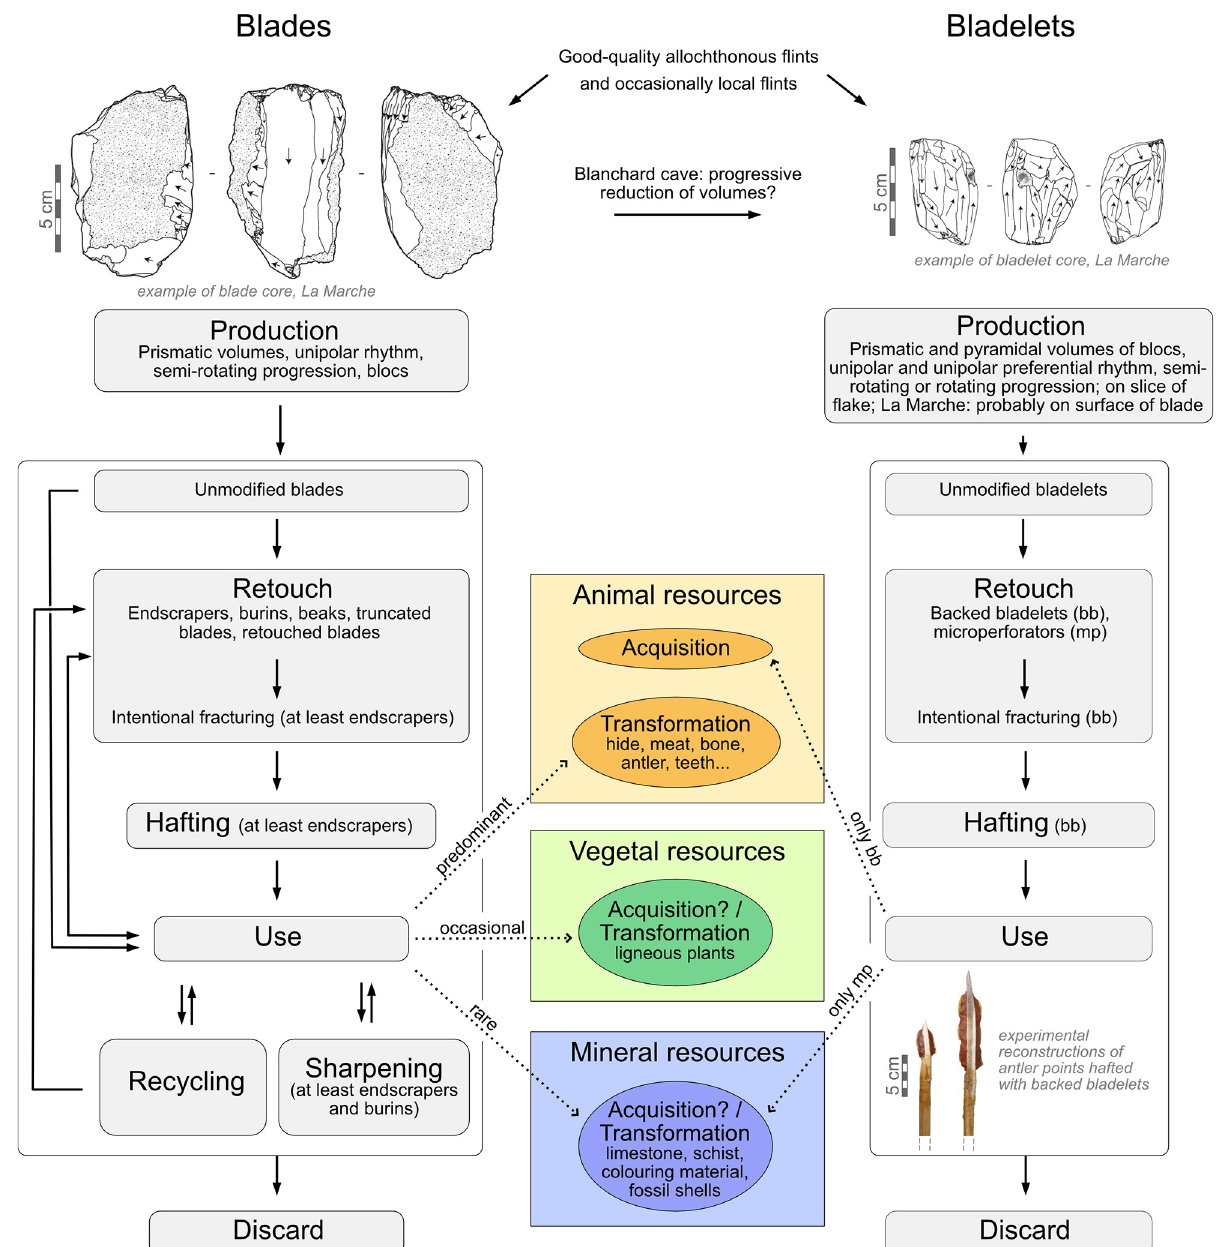
Fig 9. General chaîne opératoire from production to discard of blades and bladelets evidenced at La Marche and the Blanchard cave.